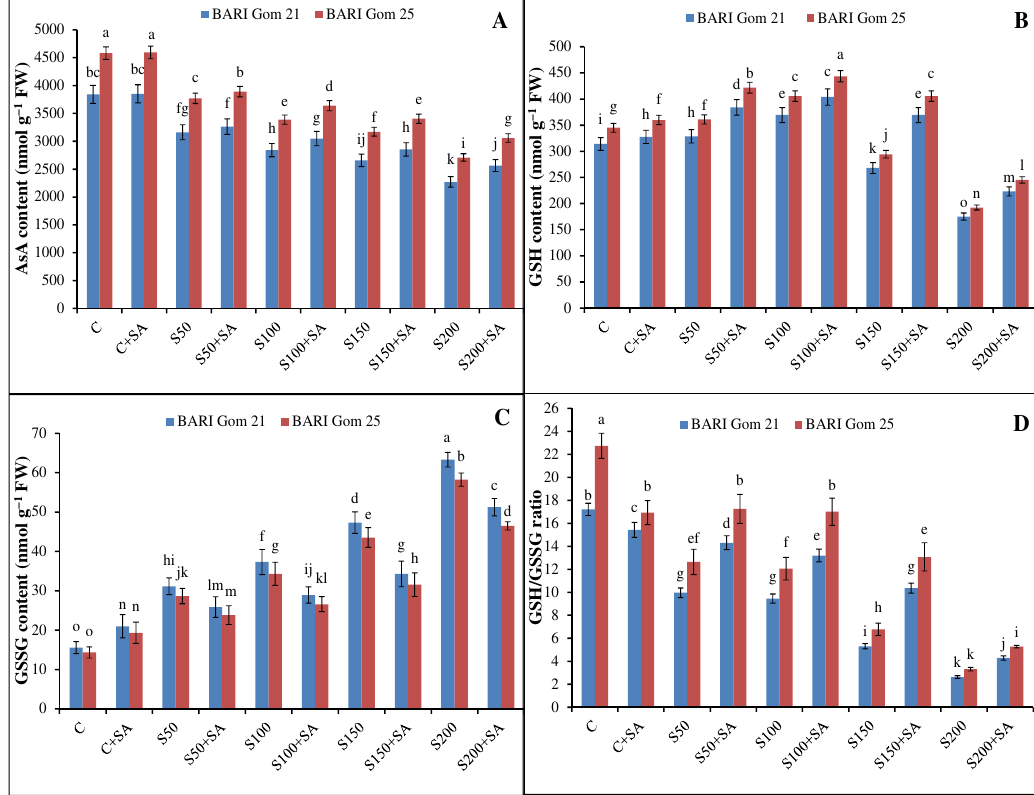
Fig. 3. ( A ) AsA content, ( B ) GSH content, ( C ) GSSG content and ( D ) GSH/GSSG ratio in salt sensitive and salt tolerant wheat plants induced by exogenous salicylic acid under salt stress. S50, S100, S150 and S200 indicate 50 mM, 100 mM, 150 mM and 200 mM NaCl, respectively. SA indicates 1 mM salicylic acid spray, respectively. Mean (±SD) was calculated from three replicates for each treatment. Values in a column with different letters are significantly different at p ≤ 0.05 applying LSD